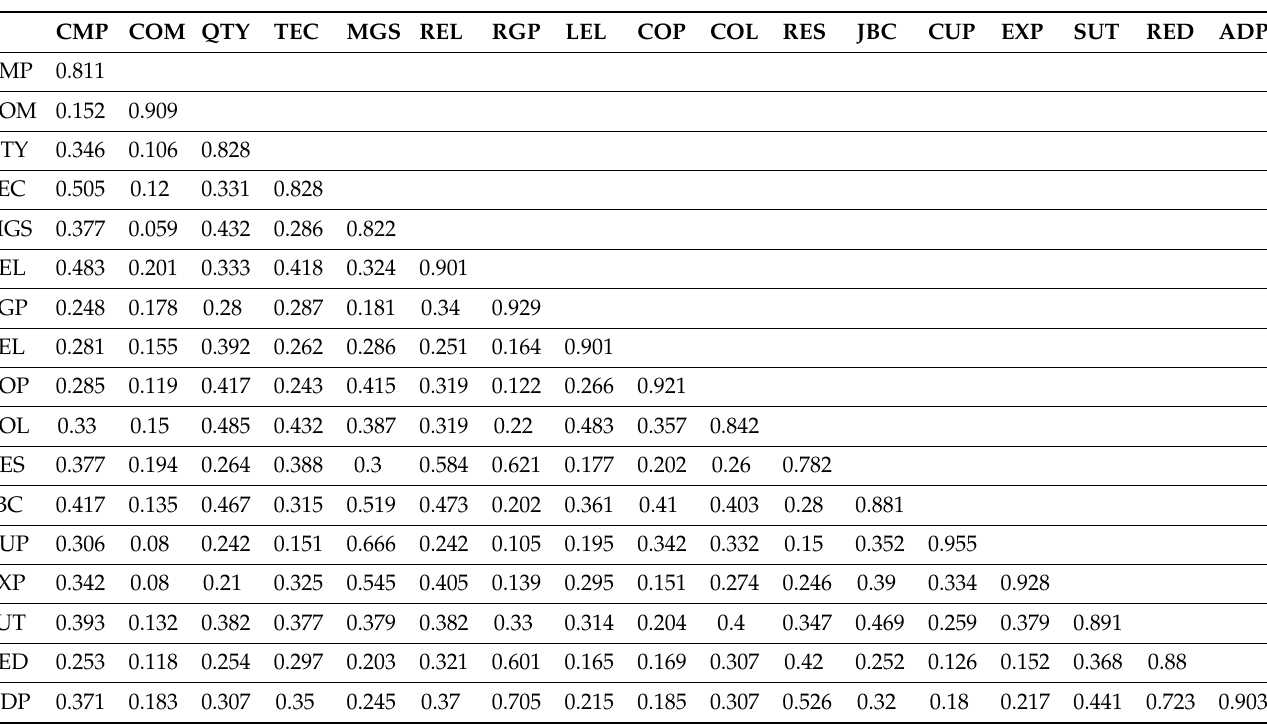
Table 6. Discriminant validity analysis.